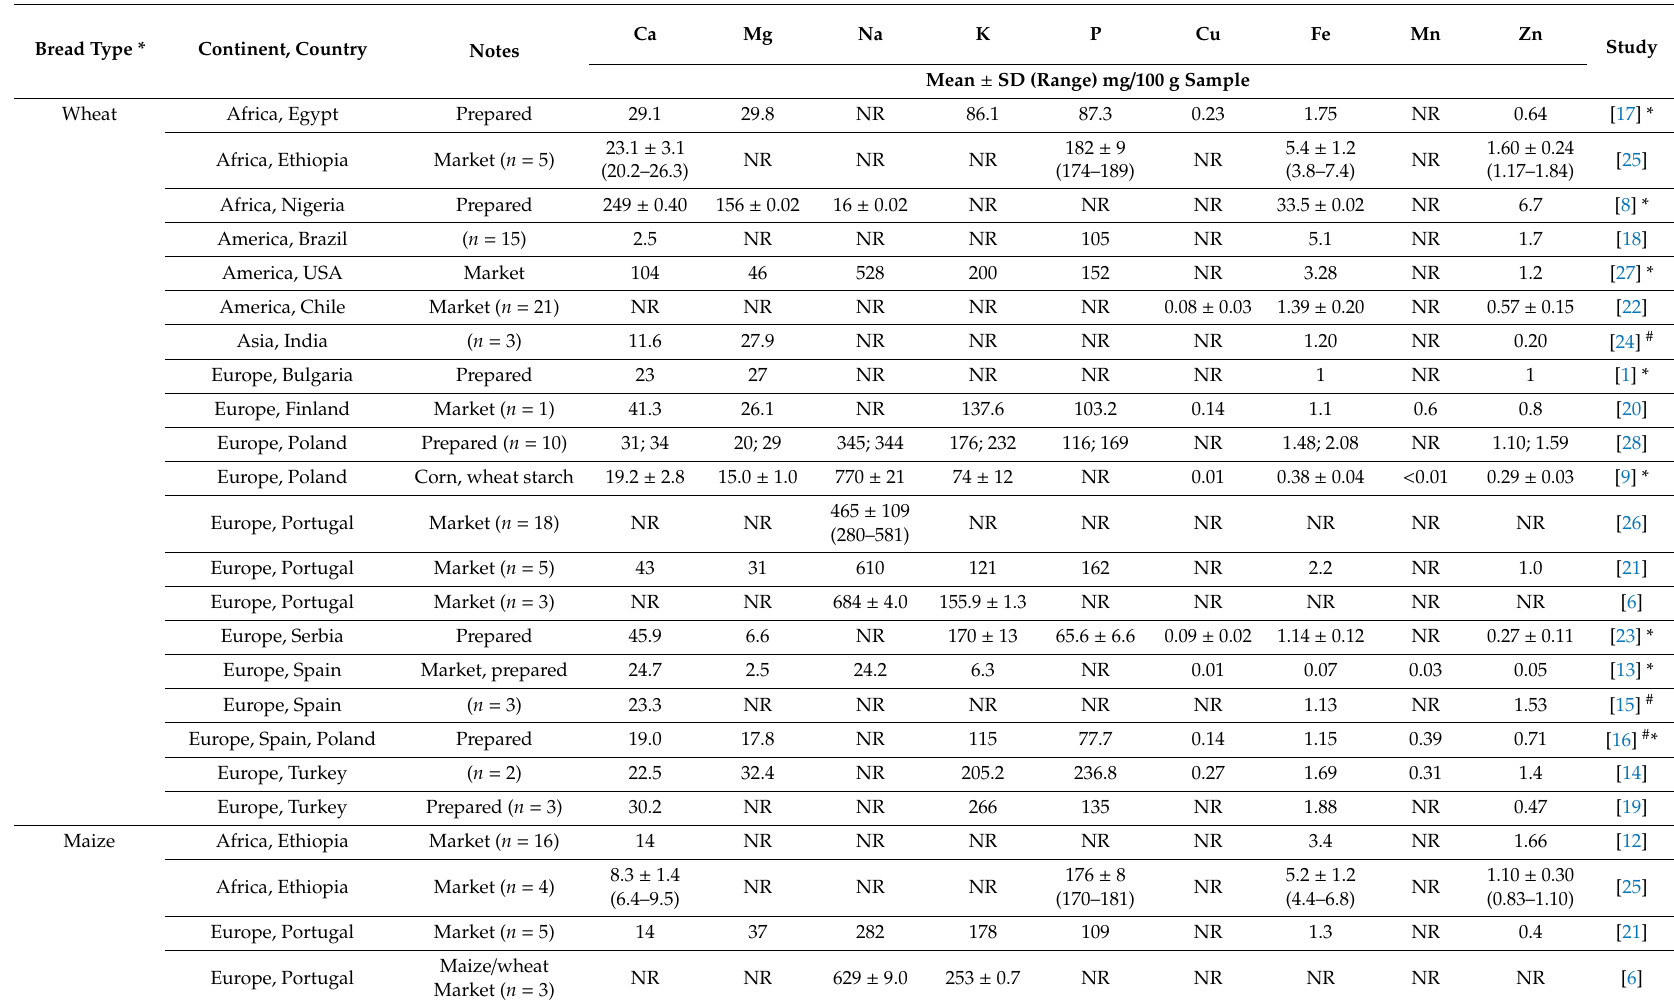
Table 1. Review of bread mineral content (mean ± SD and range; mg / 100 g wet weight (ww)) reported in the literature (2000–2017). Bread Type